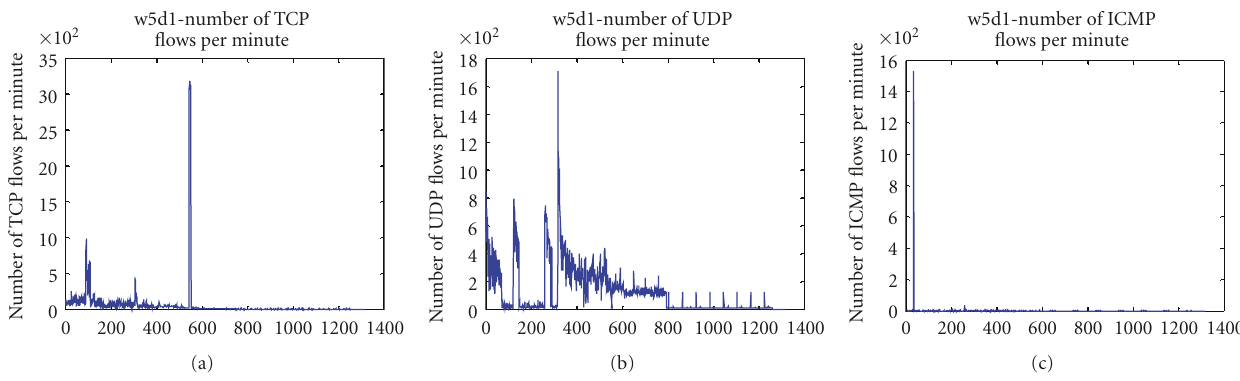
Figure 3: Number of flows per minute over one day with normal and attacking tra ffi